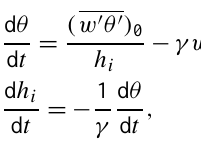
advection of potential temperature which vertically shifts the temperature